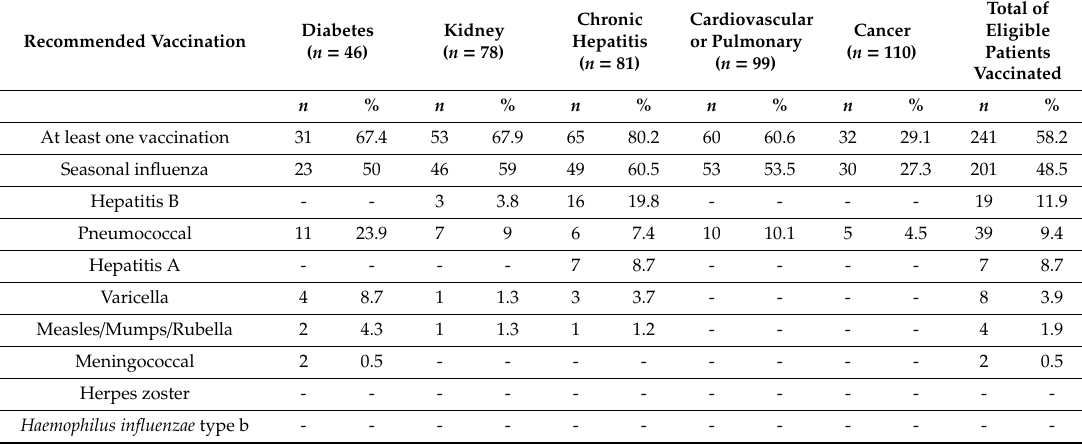
Table 3. Self-reported recommended vaccinations coverage for patients with specific chronic